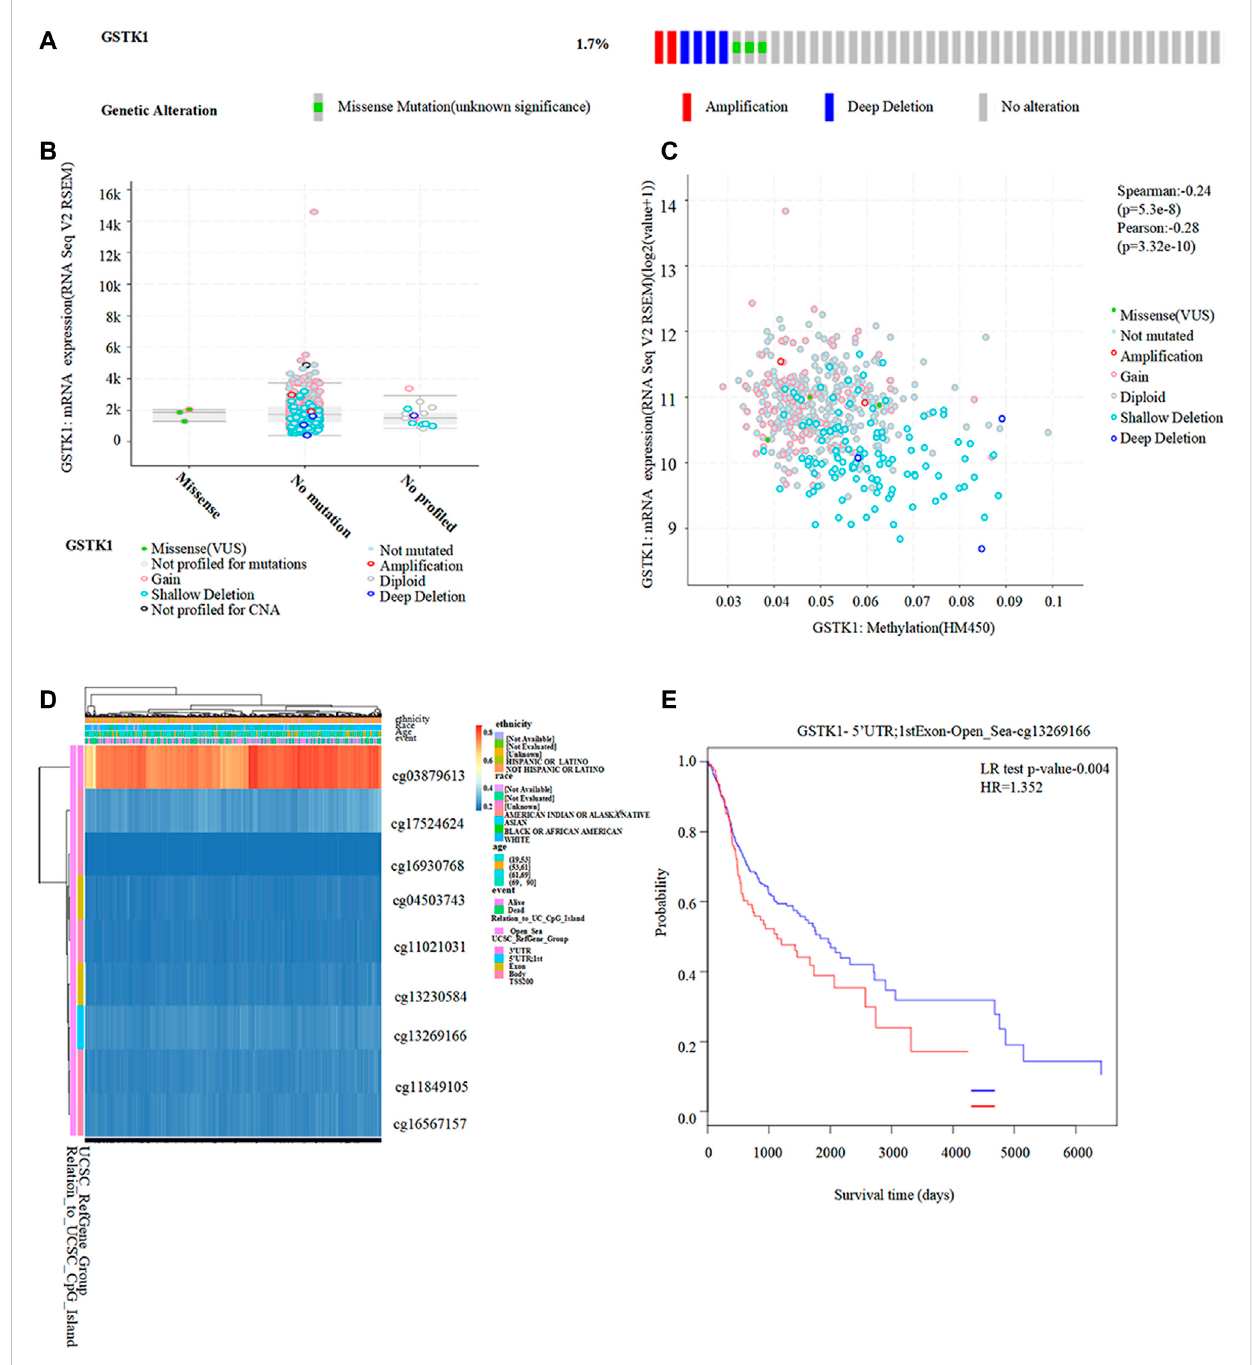
FIGURE 7 Correlation betweenGSTK1 expression and methylation in HNSC. (A, B) Geneticalterations in GSTK1and their association with GSTK1 expressionin HNSC patients using cBioportal. (C) Methylation levels of GSTK1 signi fi cantly correlated GSTK1 expression using cBioportal. (D) Visualization comparing methylation level and the GSTK1 expression. (E) Kaplan-Meier survival of the promoter methylation of